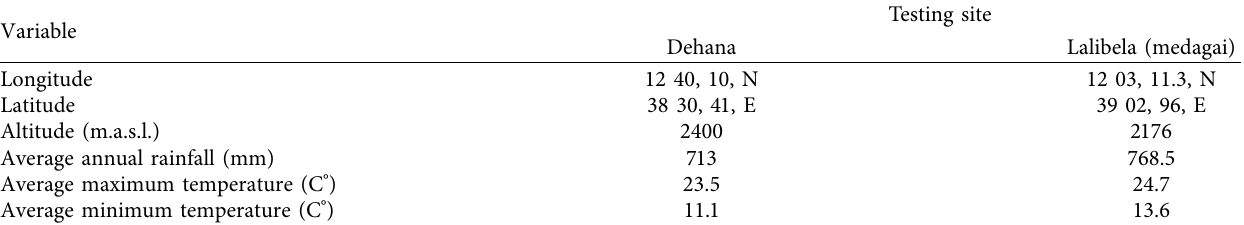
Table 1: Some descriptions of the testing sites. The rainfall and the temperature were the average of the two years (2016 and 2017). Variable